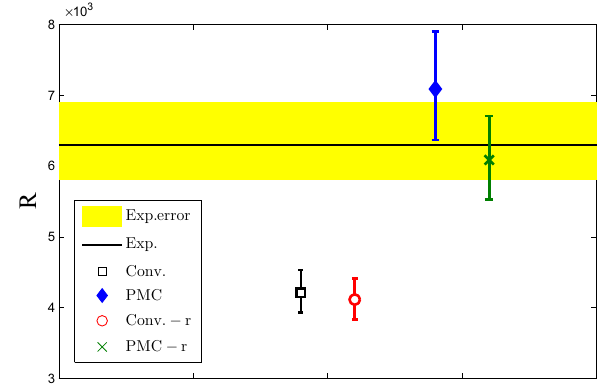
Fig. 2 Uncertainties of R under the mMOM-scheme from the c -quark polemass m c andtheasymptoticscale (cid:4) mMOM ,wheretheerrorbarsare squaredaveragesoftheerrorsfromthosetwoerrorsources.Thesymbol “ − r ” stands for corresponding relativistic corrections. The experimen- tal prediction of Ref. [1] is presented as a